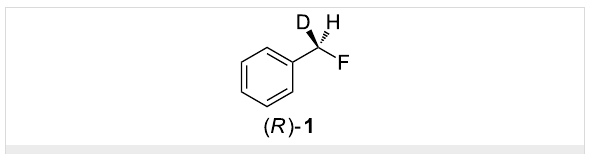
Figure 2: 7-[ 2 H 1 ]-( R )-Benzyl fluoride (( R )- 1